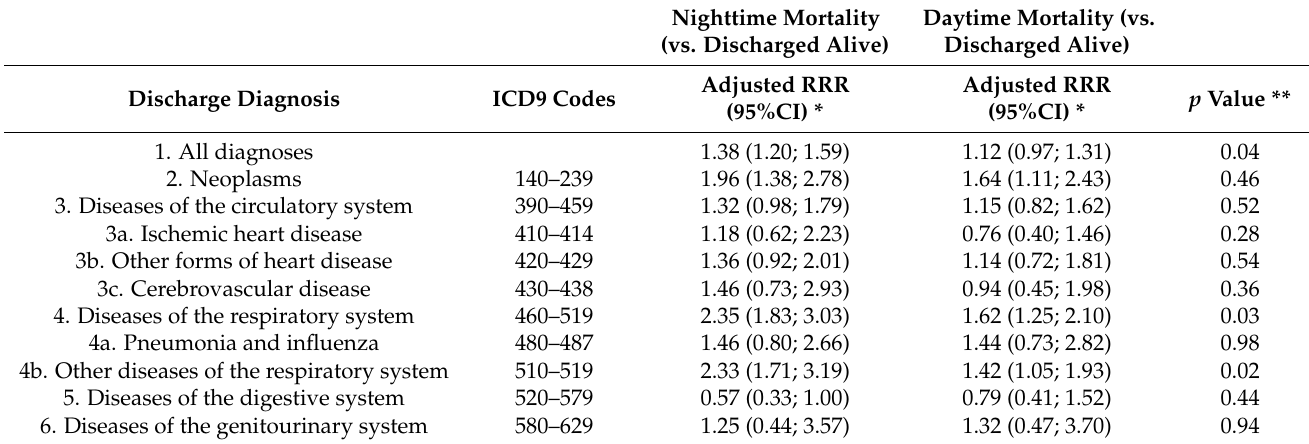
Table 5. Relative Risk Ratios (RRRs) with 95% CIs for the association between admission during organizational Model 2 (vs. Model 1) and nighttime or daytime mortality by discharge diagnosis. Nighttime Mortality Daytime Mortality (vs. Discharged Alive)